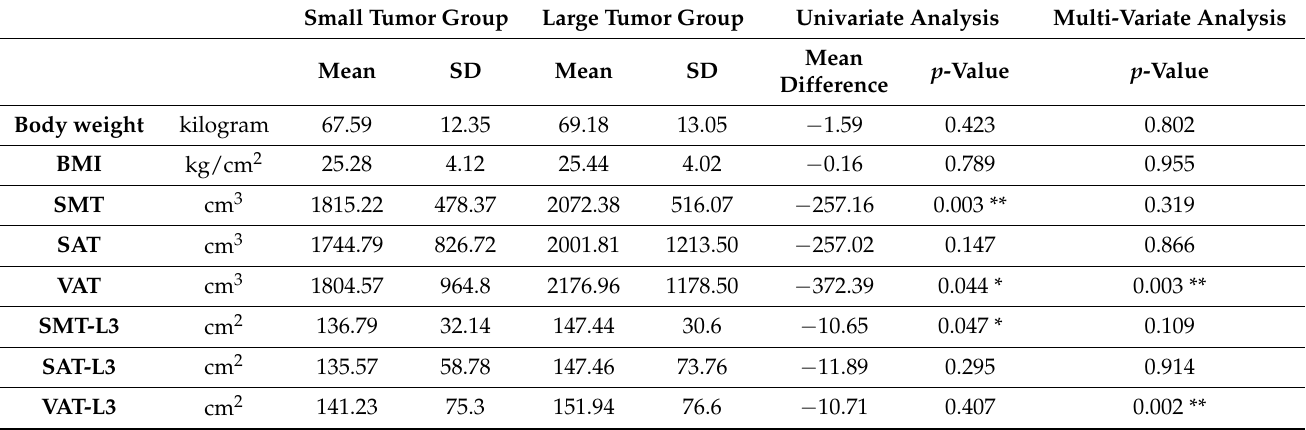
Table 4. Correlation Analysis Between Tumor Size and Body Composition in localized